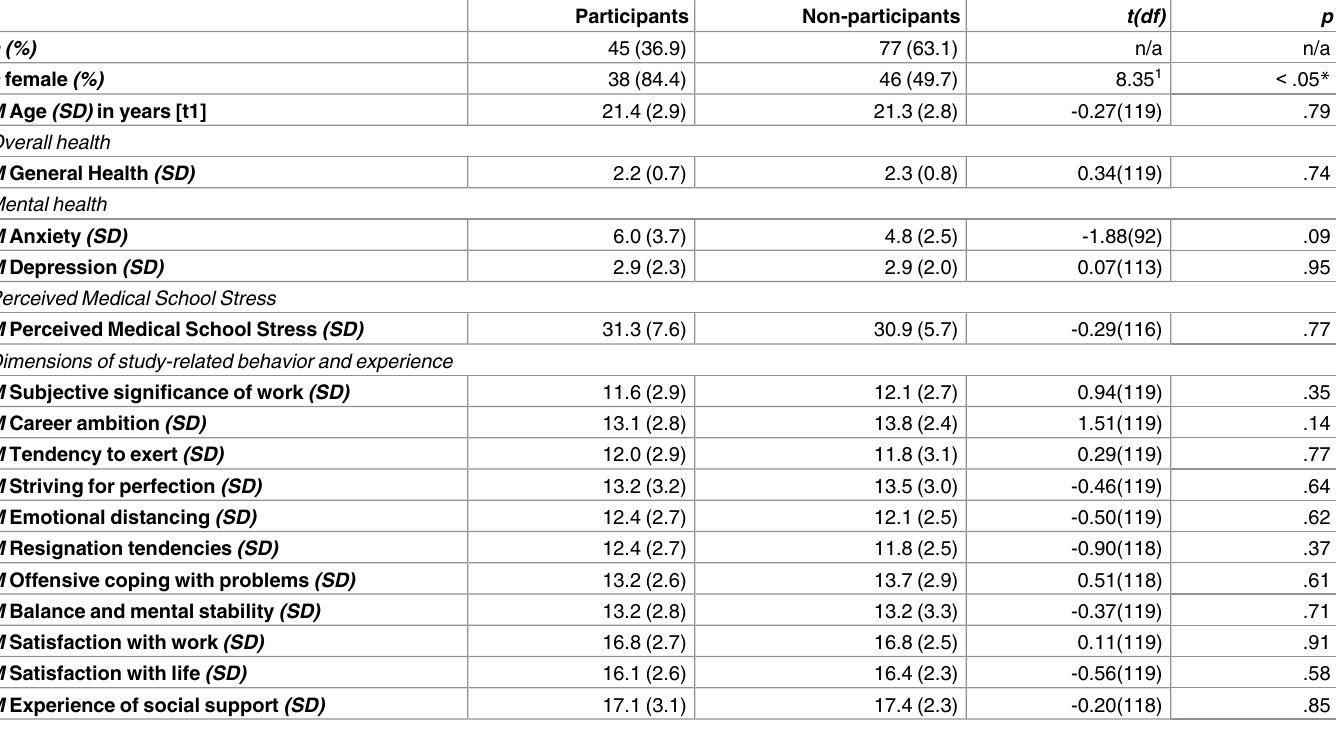
Table 2. Bivariate differences between intervention participants and non-participants.